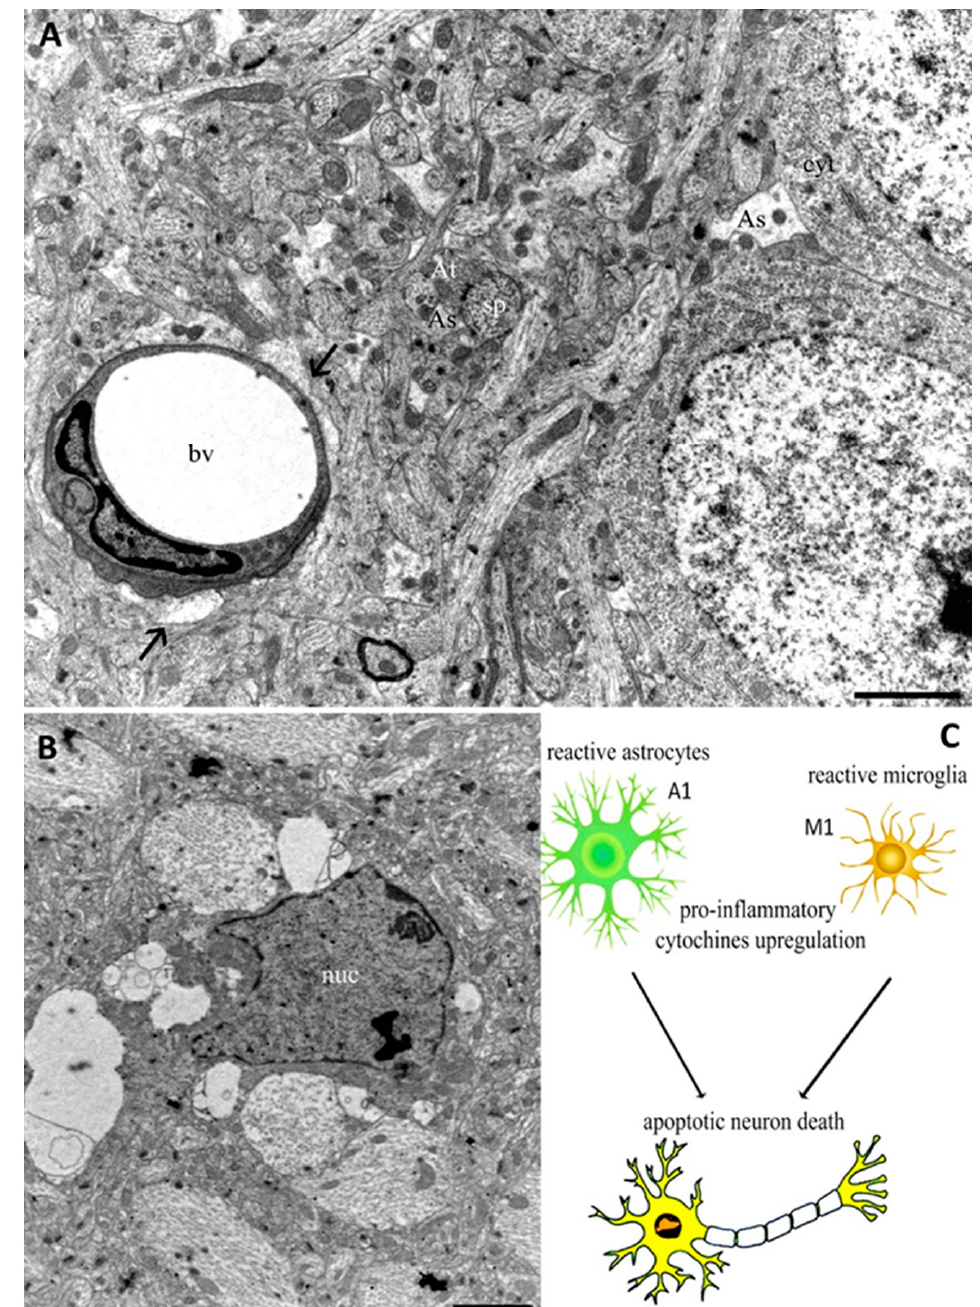
Figure 1. Transmission Electron Microscopy (TEM) images from cerebral cortex of adult rat ( A , B ). In ( A ), astrocyte end feet protrusions (arrows) can be observed near to a blood vessel (bv). Astrocyte processes (As) appear near axonal terminal (At) and dendritic spines (sp), as well as around neuron cytoplasm (cyt). The micrograph ( B ) shows a microglia cell characterized by a nucleus (nuc) with an irregular outline in which the chromatin is clumped beneath the nuclear envelope. The schematic representation of glia activation related to neuron death appears in ( C ). Bars 2 µm for ( A ) and ( B ).